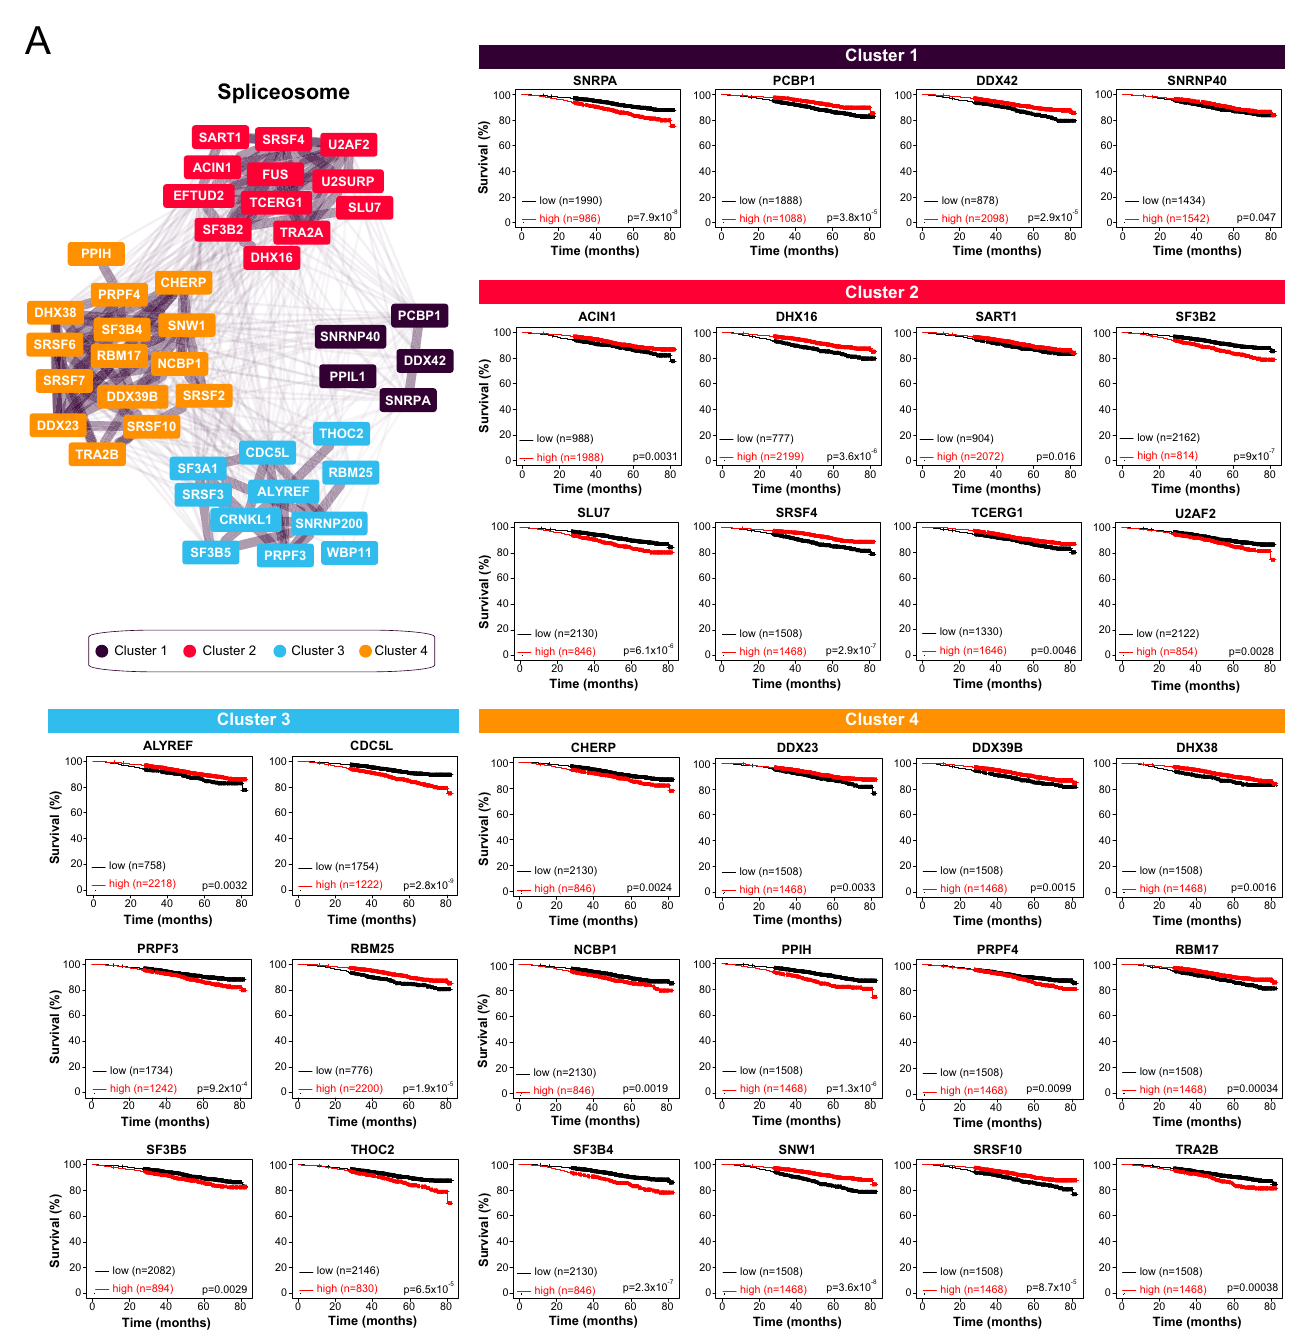
Fig 5. Several splicing factors that are proximal to the RAD51 paralogs have prognostic potential in BC. (A) Overall survival analysis based on the RNA levels of the indicated splicing factors in a cohort of BC patients using KMplot (n = 2976 patients). Only the preys linked to the spliceosome that have a significant impact on BC overall survival (p < 0.05) are